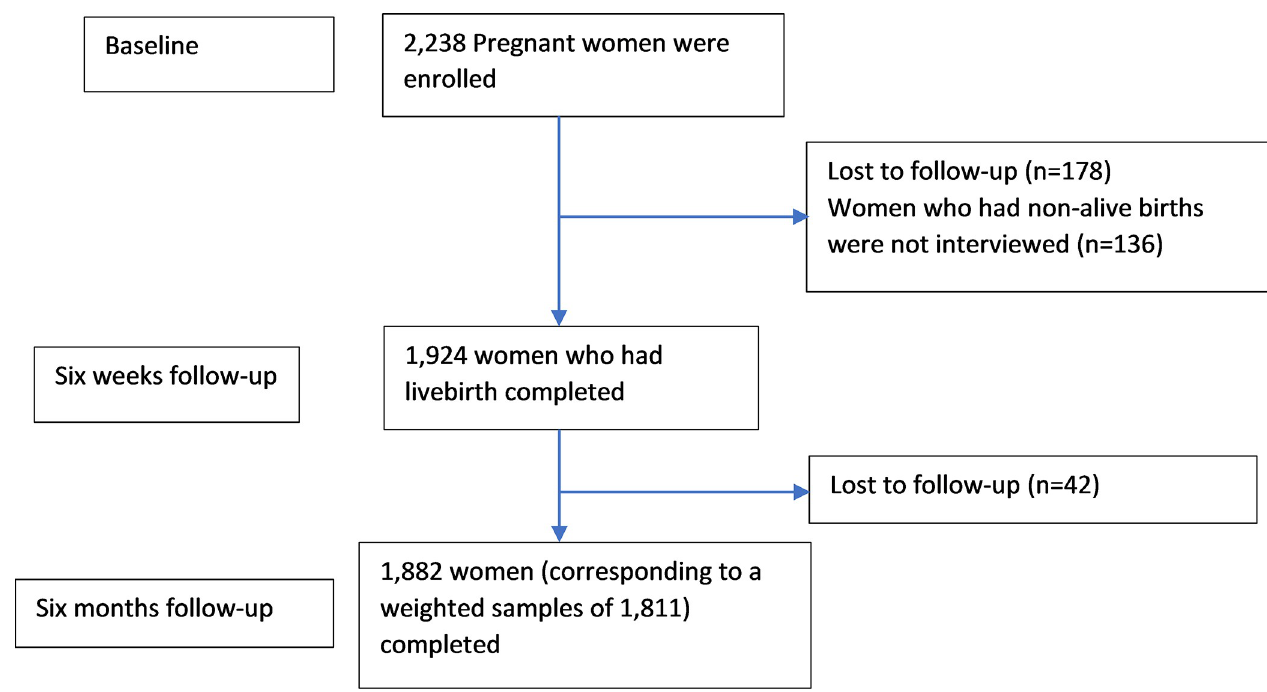
Fig 1. Flow diagram of participant’s’ progress through the